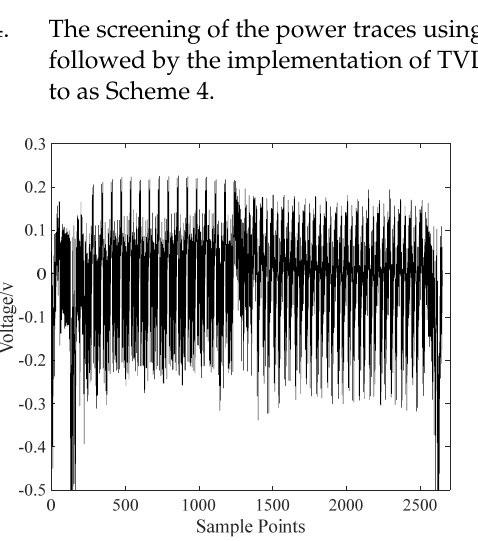
Figure 3. A piece of power trace collected from the Chipwhisperer MCU platform.